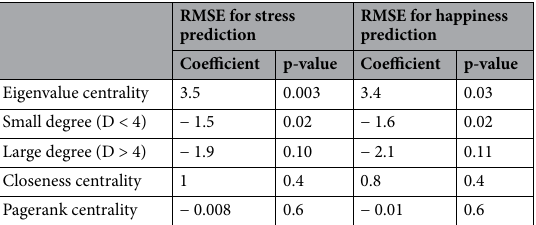
Table 2. GEE results with model prediction RMSE as dependent variable and node centrality metrics as independent variables.